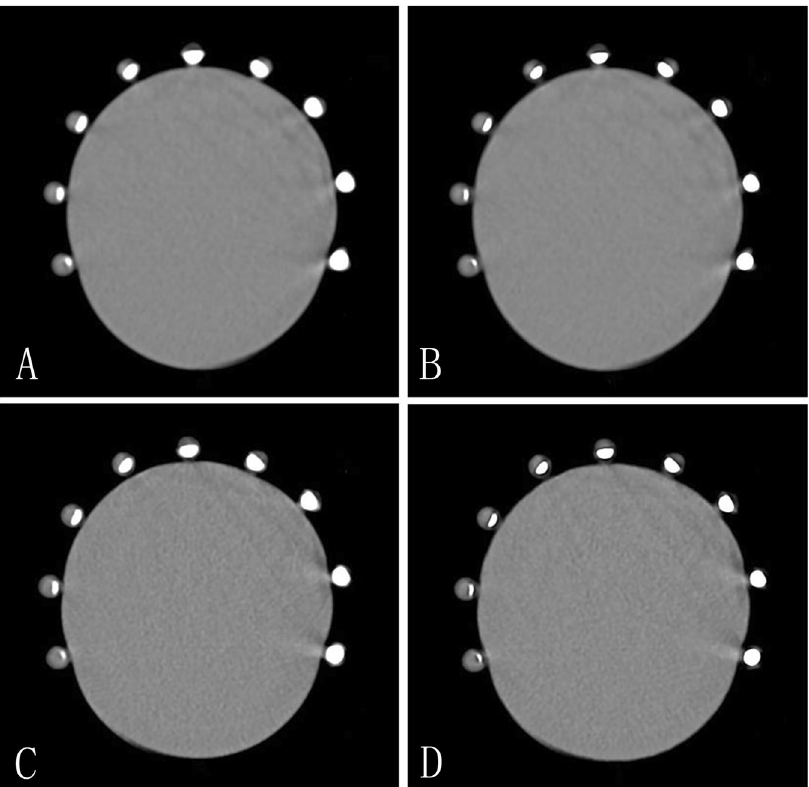
Figure 2. Axial CT images of the coronary vessel phantom of nine stenosis models with calcified plaques. Clockwise, in turn, is 10%, 20%, 30%, 40%, 50%, 60%, 70%, 80%, and 90% stenosis. ( A ) nine different stenoses of calcified plaques without de-blooming algorithm using standard mode reconstruction. ( B ) nine different stenoses of calcified plaques using standard mode reconstruction with de-blooming algorithm. The degree of stenosis of calcified plaques was less severe due to suppression of blooming artifacts as observed in B when compared to A. ( C ) nine different stenoses of calcified plaques using high definition standard mode reconstruction without de-blooming algorithm. The degree of stenosis of calcified plaques was less severe compared to images on A, but was more serious when compared to images on B. ( D ) nine different stenoses of calcified plaques using high definition standard mode reconstruction with de-blooming algorithm, compared with B and C, the degree of stenosis of calcified plaques was less obvious.